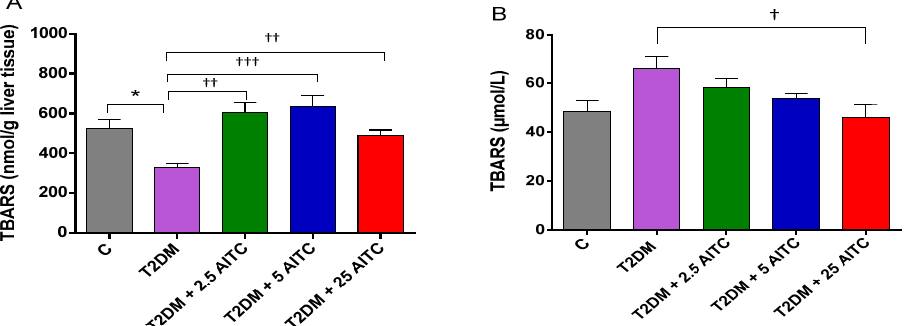
Figure 4. Effects of AITC on thiobarbituric acid reactive substances (TBARS) amount in the liver ( A ) and in the blood serum ( B ) of diabetic rats. Each column represents the mean ± SEM ( n = 8). * p ≤